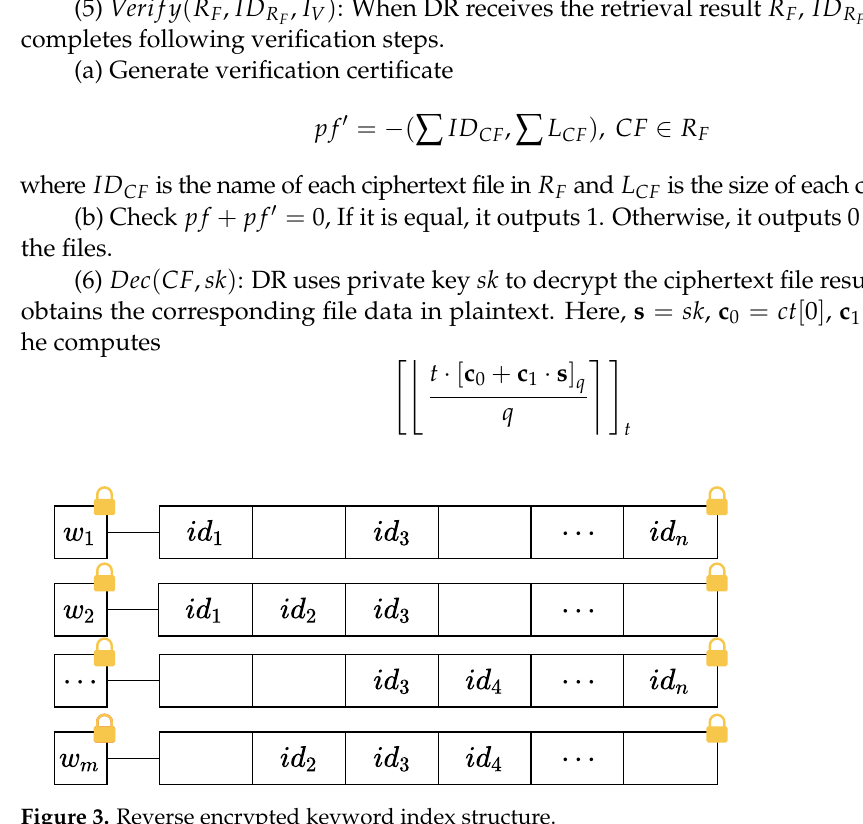
Figure 3. Reverse encrypted keyword index structure.